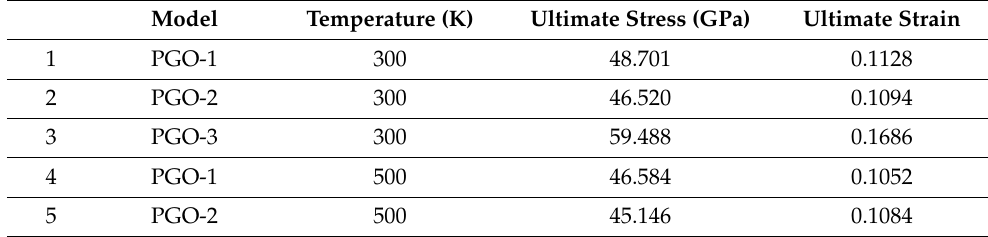
Table 3. Uniaxial tensile results using different